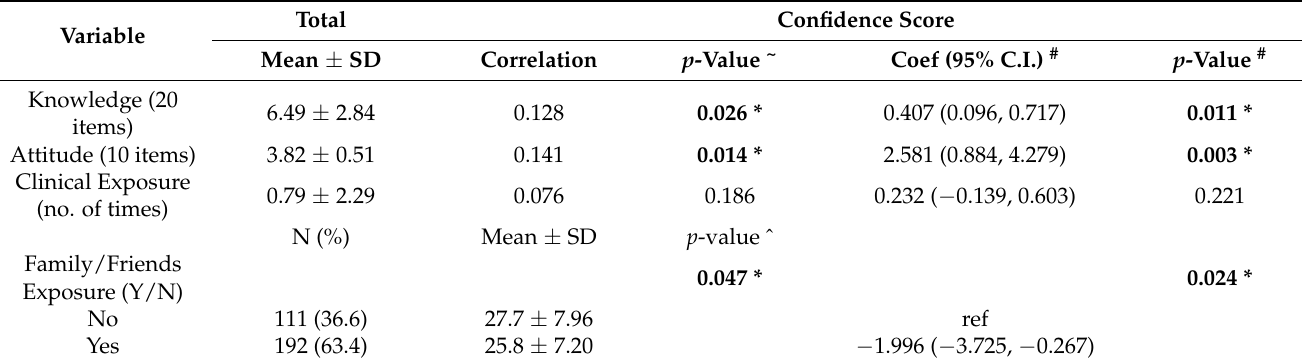
Table 2. Factors associated with the confidence towards providing palliative care among medical students.